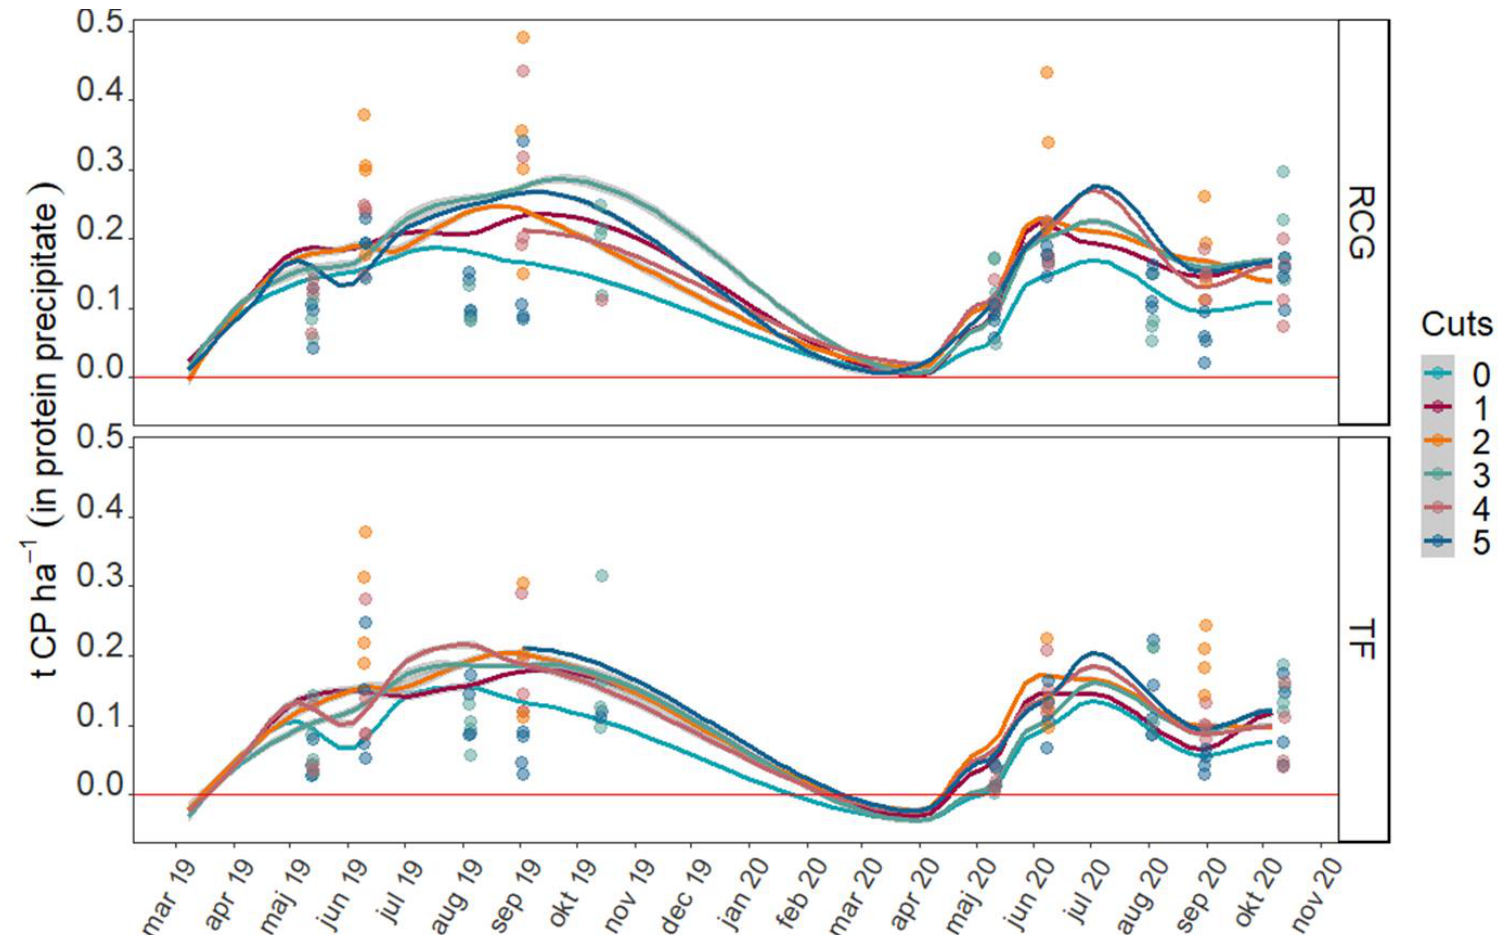
Figure A3. RVI model output for the species Phalaris arundinacea (RCG) and Festuca arundinacea (TF) over the years 2019 and 2020. Lines show modelled crude protein (CP) in protein precipitate yields (t ha -1 ) per date and treatment. Harvest frequencies are indicated by 0–5 annual cuts and dots show measured